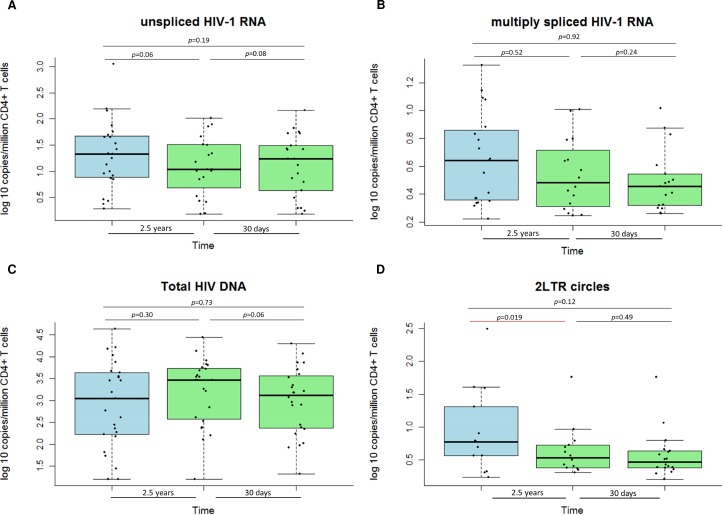
Viral reservoir dynamics.Long and short-term dynamics of cellular markers of HIV-1 persistence. A) unspliced HIV-1 RNA; B) multiply spliced HIV-1 RNA; C) Total HIV-1 DNA; and D) 2LTR circles. *Of note: all analysis was performed using non-parametric statistics.